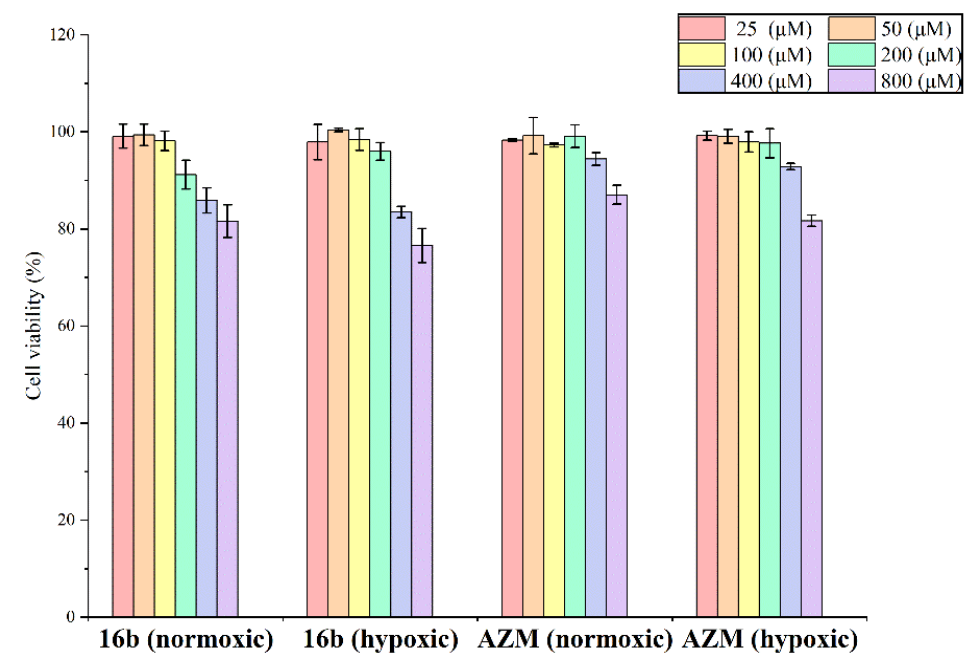
Figure 3. Effects of compounds 16b and AZM on the cell viability of MG-63 cell under normoxic and hypoxic